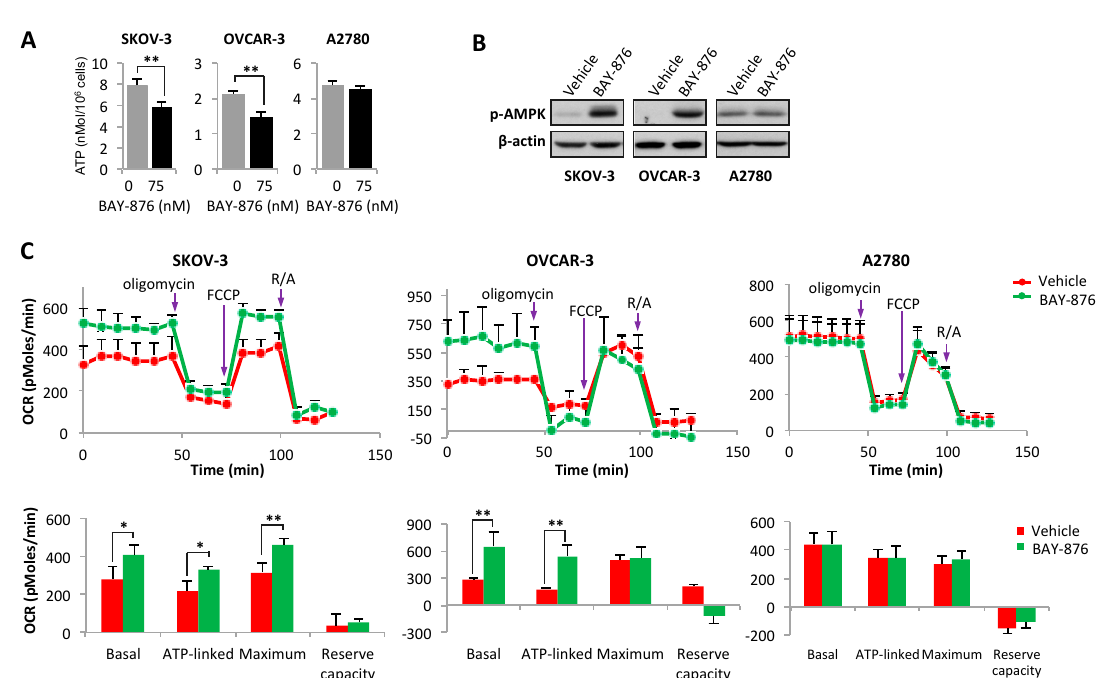
Figure 3. Inhibition of GLUT1 decreases ATP, activates AMPK and enhances OCR. SKOV-3, OVCAR-3 and A2780 cells were treated with vehicle or BAY-876 (75 nM). Cellular ATP contents (nMol of ATP in 10 6 cells) ( A ), and levels of phosphorylated AMPK α ( B ) were determined with an ATP bioluminescence assay and immunoblotting analysis, respectively. In ( C ), OCR in these cell lines treated with vehicle or BAY-876 (75 nM) was measured with the Seahorse XF24 Analyzer as detailed in Materials and Methods. The background in cell-free wells was subtracted from readings of all other wells. The presented in upper panel were real time OCRs (pMoles/min, mean ± SD of triplicate assay) over the course of measurement. In lower panel, basal mitochondrial respiration (Basal), ATP-linked respiration (ATP-linked), maximal respiratory capacity (Maximum) and Reserve capacity were calculated and statistically analyzed to show the effects of BAY-876. * p < 0.05; ** p < 0.01.